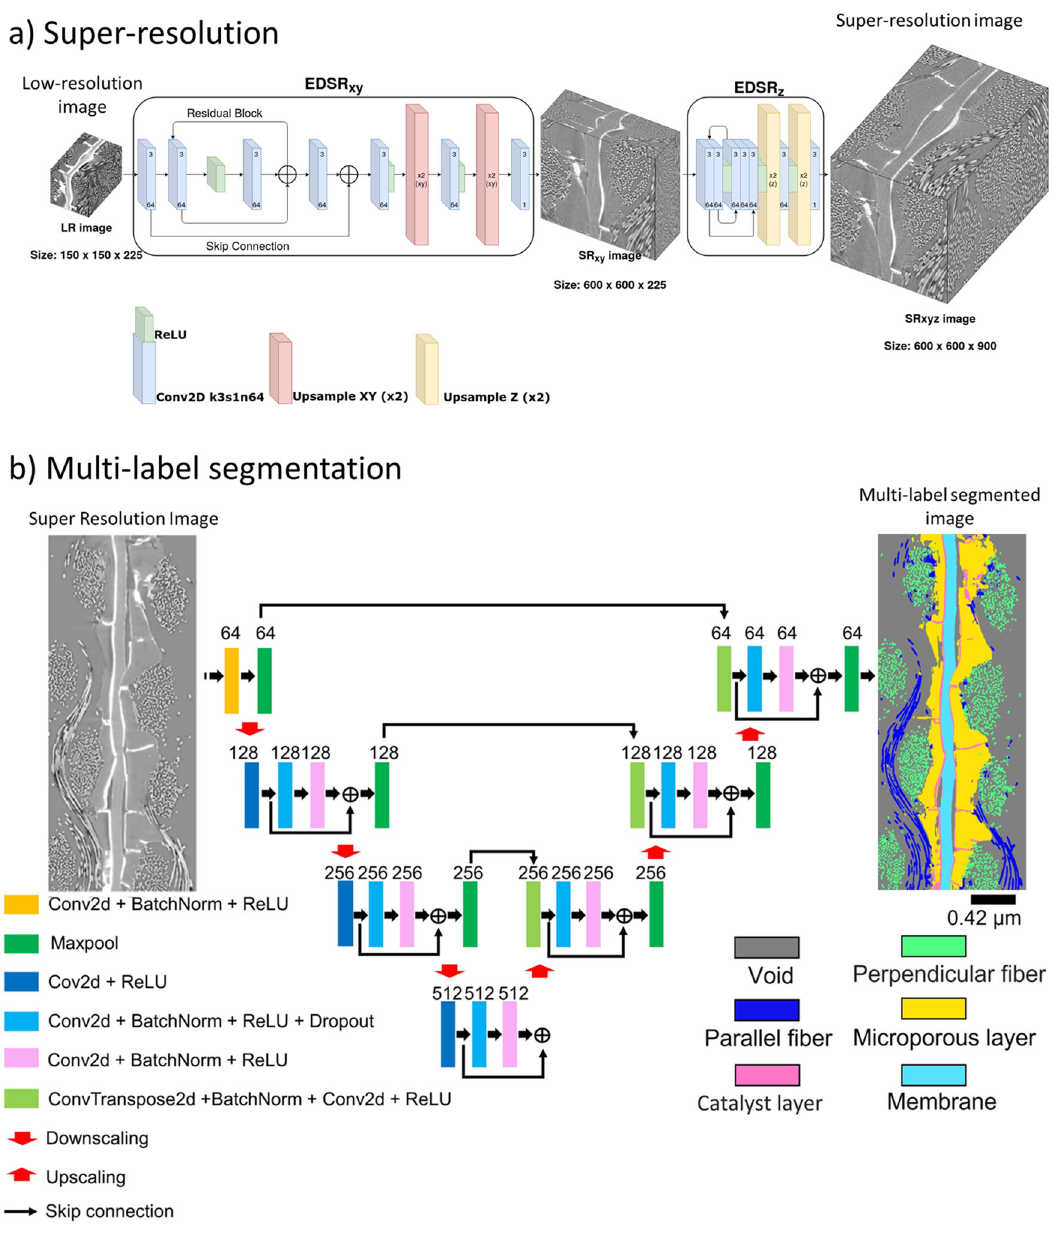
Fig. 7 | CNN architectures for super-resolution and multi-label segmentation. a Network architectureof DualEDSR — composed of 2 EDSR networks in series with appropriate upsampling layers. b Architecture of the U-ResNet, containing